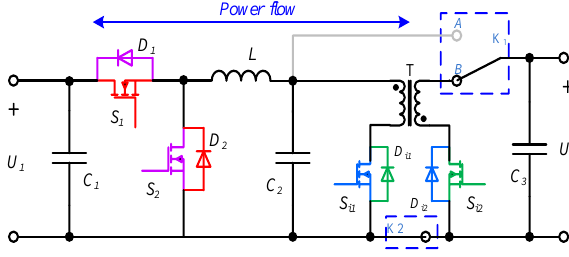
Figure 4. The equivalent circuits of the proposed converter in isolated operation.